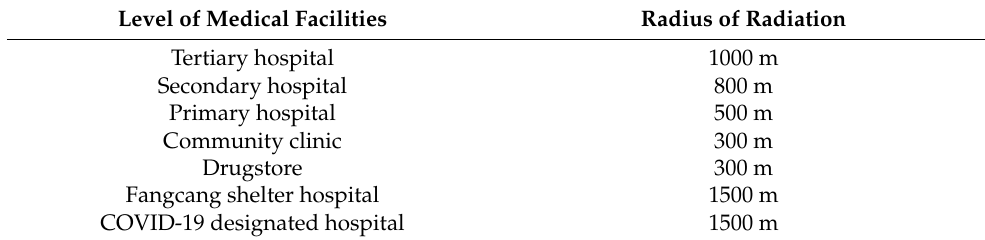
Table 4. Radiation radius of medical